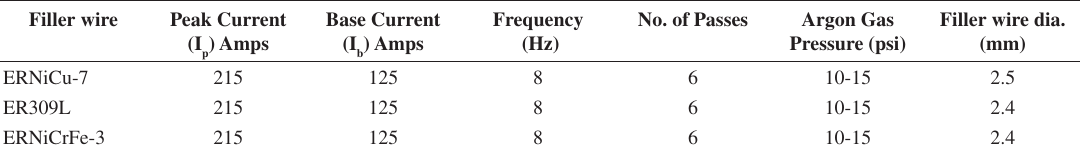
Table 2. PCGTA Weld process parameters for Monel 400 and AOSO